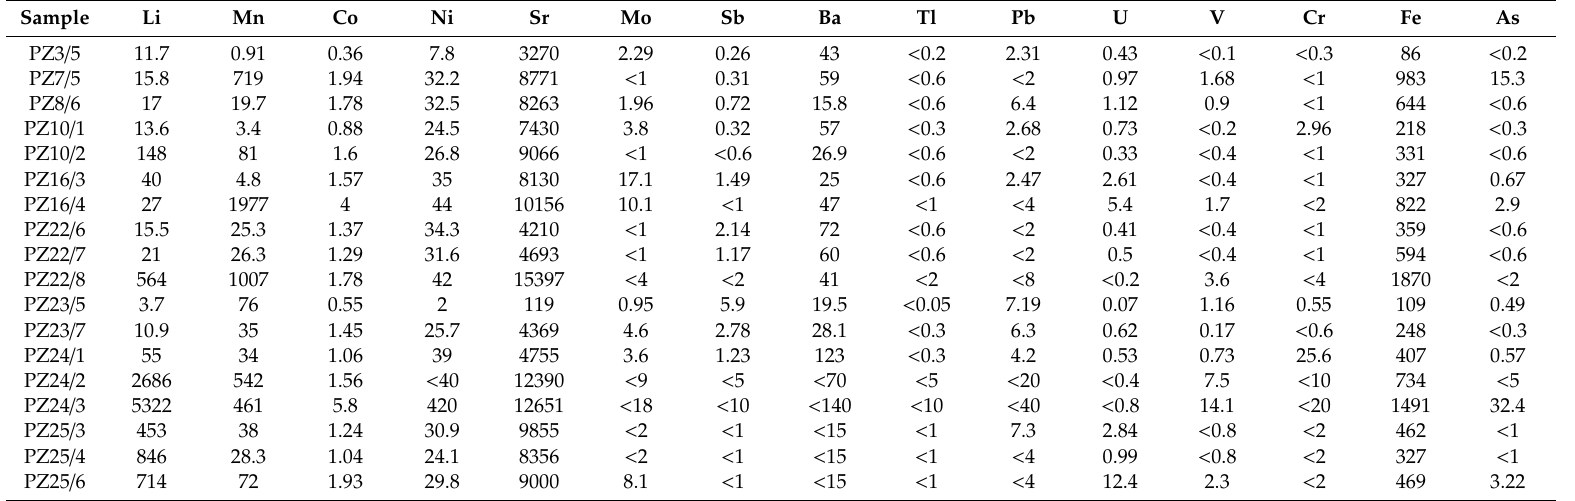
Table 3. Trace element analysis ( µ g / L). Values < DL (detection limit) are